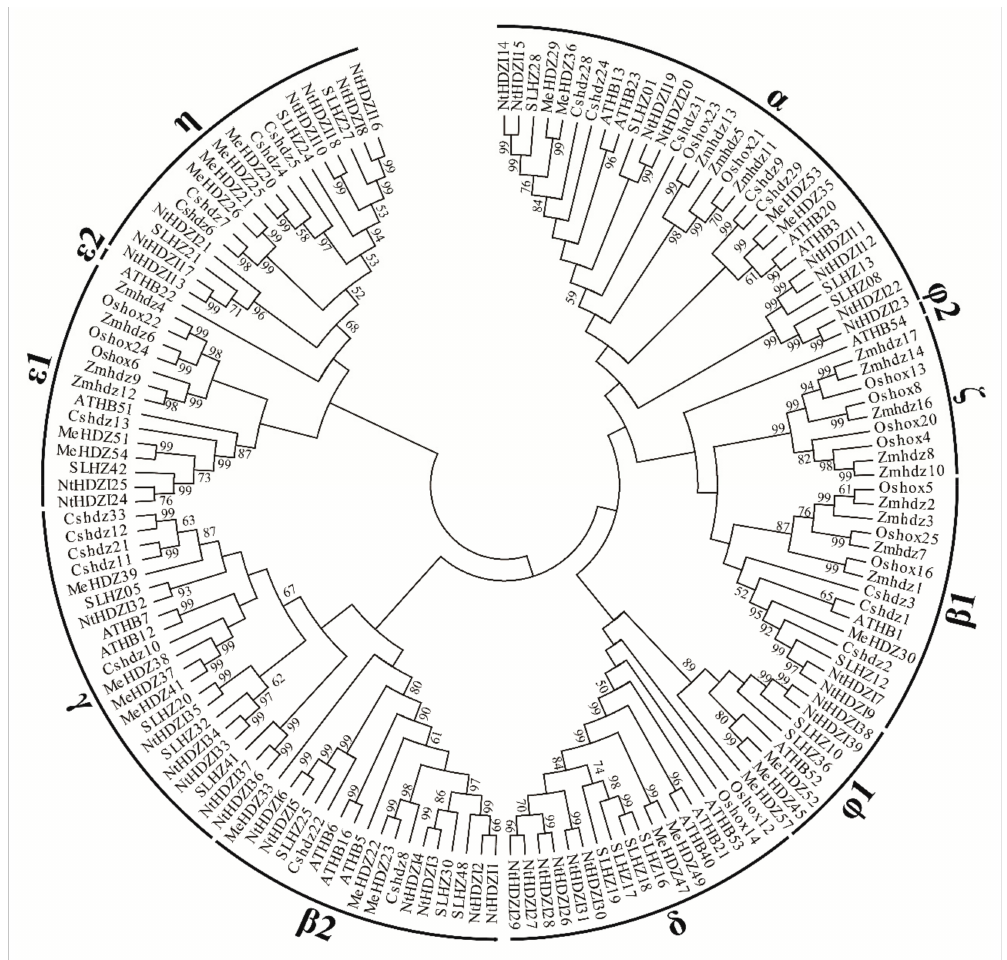
Figure 1. Phylogenetic analysis of HD-Zip I proteins from tobacco and other plants. The phylogenetic tree was constructed using 39, 17, 22, 14, 23, 16, and 20 HD-Zip I protein sequences from N. tabacum , A. thaliana , S. lycopersicum , O. sativa , Cassava , Maize , and C. sinensis , respectively. Plant HD-Zip I members were divided into eleven